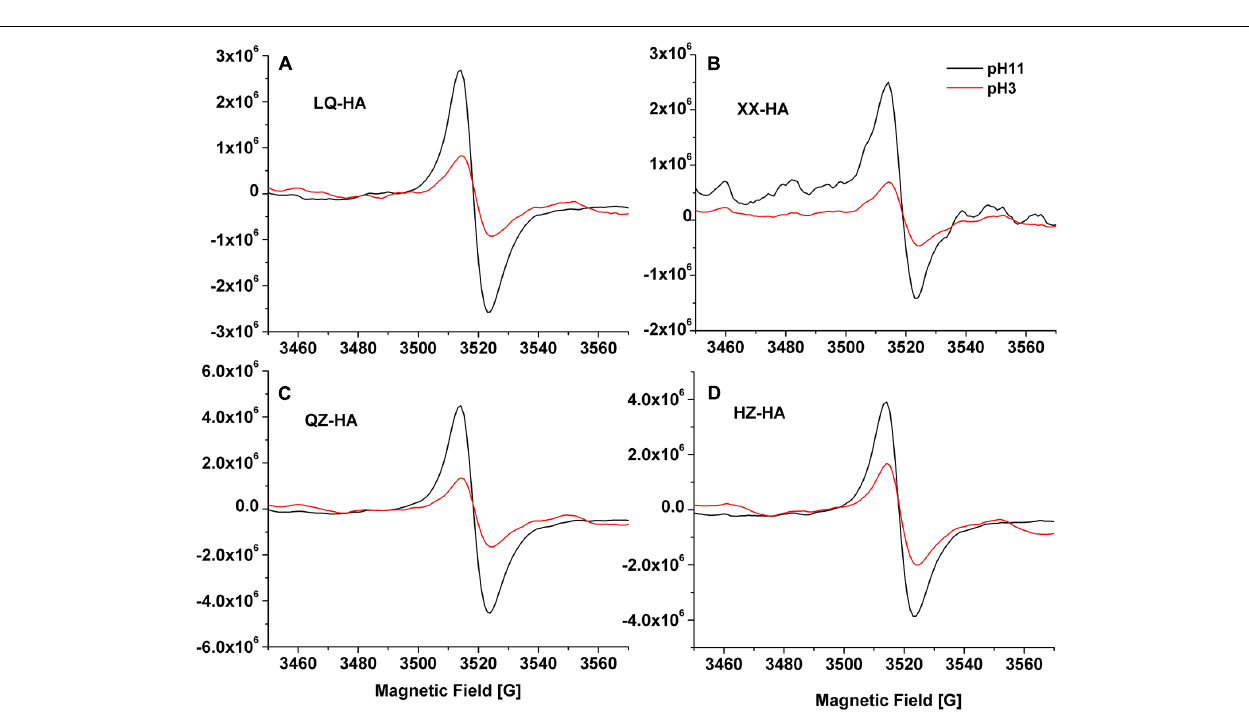
FIGURE 3 | Electron Spin Resonance (ESR) spectra of different HAs [LQ-HA (A) , XX-HA (B) , QZ-HA (C) , HZ-HA (D) ] samples. Abbreviated names of HAs are the same as those presented in Table 1